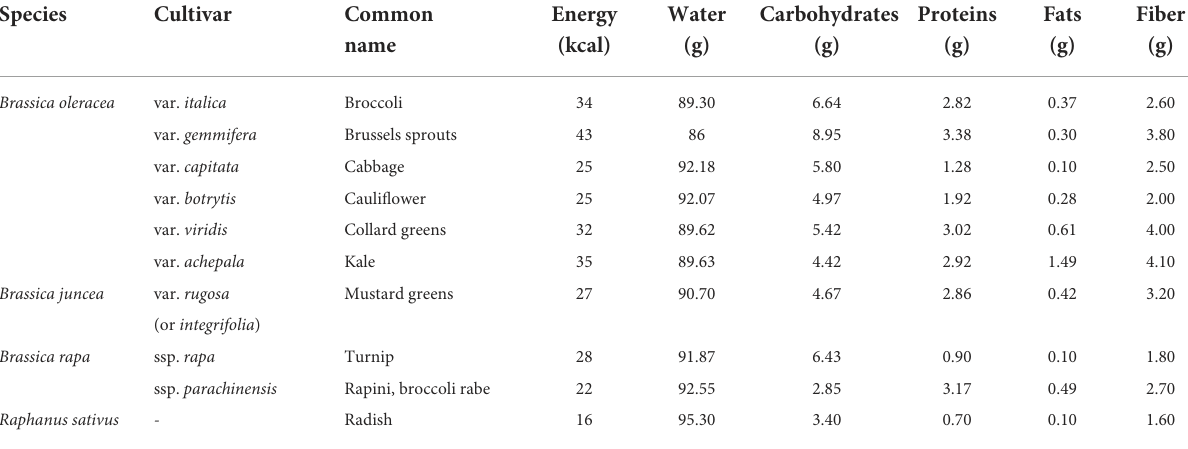
TABLE 1 Macronutrients of cruciferous vegetables per 100g. Species